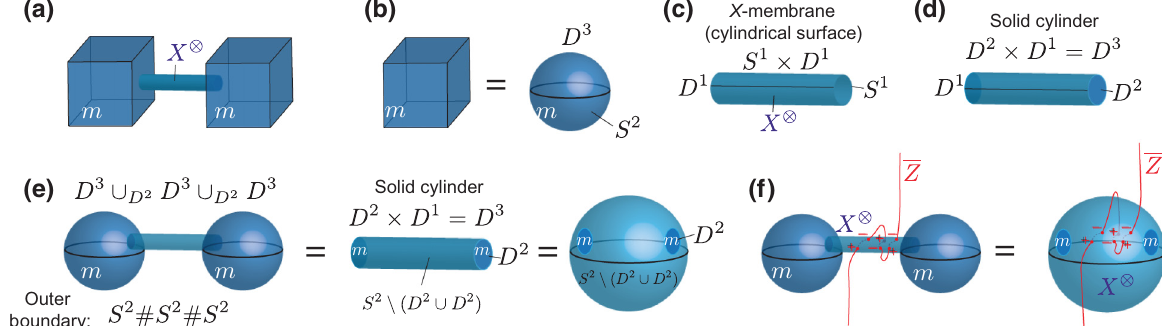
FIG. 19. An illustration for Proof 3a. (a) A local X -brane connecting two m -holes. (b) The equivalence of the m -hole to a 3-ball D 3 with the boundary being a 2-sphere S 2 . (c) The equivalence of the X -brane to a cylinder S 1 × D 1 . (d) The filled (solid) cylinder is equivalent to a 3-ball D 3 . (e) Gluing two 3-balls with a solid cylinder in between is equivalent to a solid cylinder, while its boundary is equivalent to a connected sum of three 2-spheres. Exclusion of the two m -boundaries leads to a 2-punctured sphere with two disks D 2 being removed, i.e., S 2 \ ( D 2 ∪ D 2 ) . (f) The intersection of the macroscopic logical string Z and the X -brane is equivalent to the intersection of the string with a 2-punctured sphere. The algebraic intersection is always zero since the string enters and leaves the interior of the punctured sphere the same number of